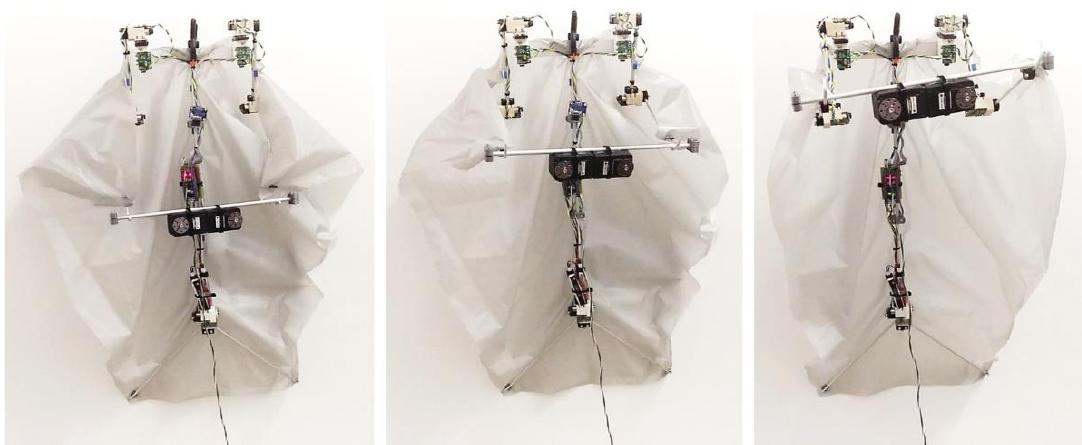
Figure 14. Sequence of images showing the lift load capacity using the dual arm.